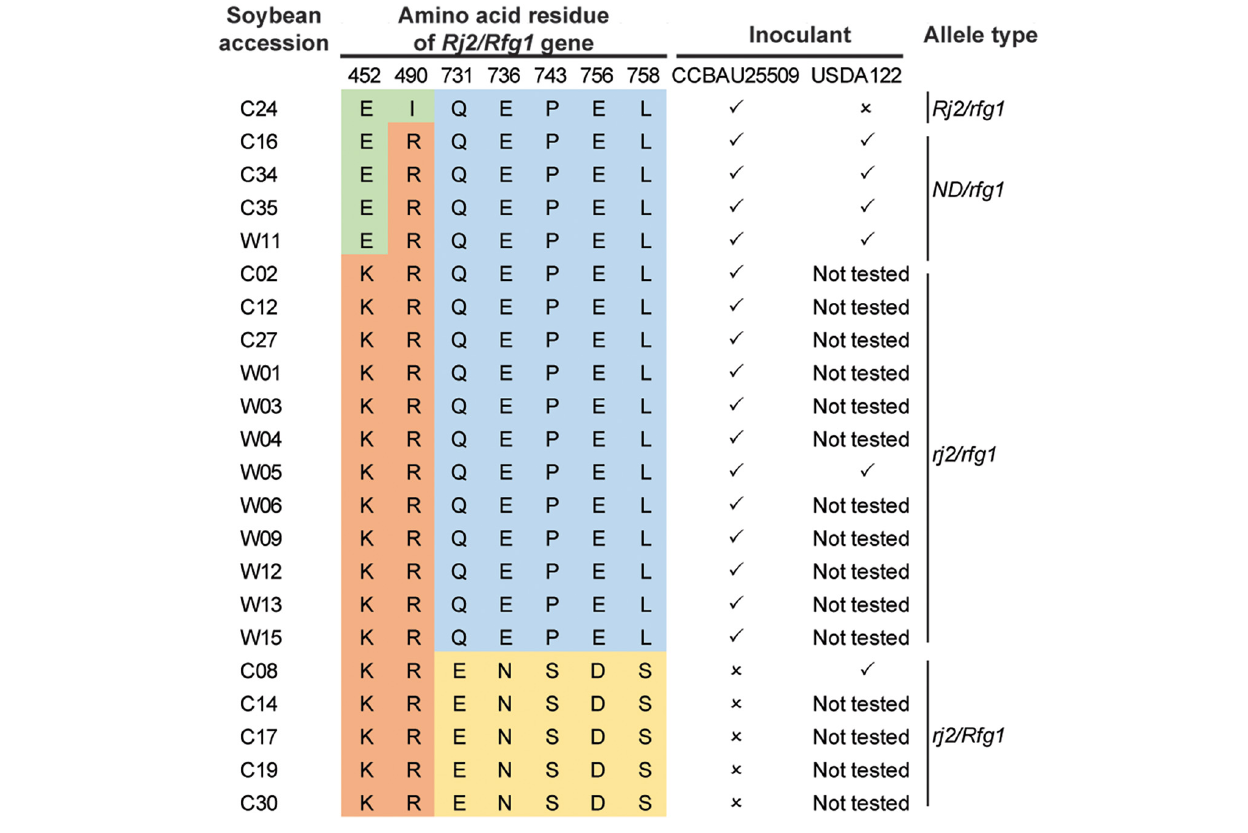
no restriction. The newly identified allelic type behaved like